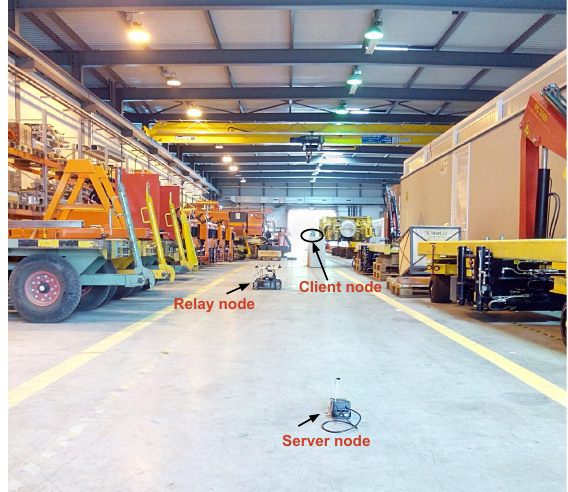
Figure 15. Experimental setup of the server-relay-client nodes at a CERN